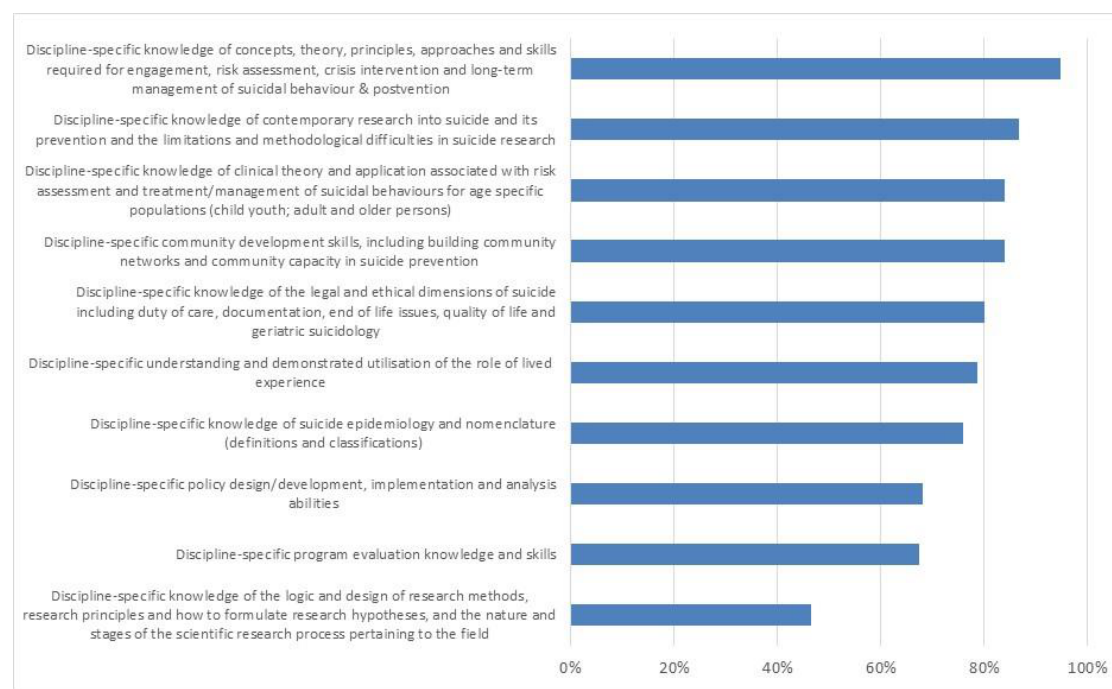
Figure 1. Perceived importance of the key learning domains.